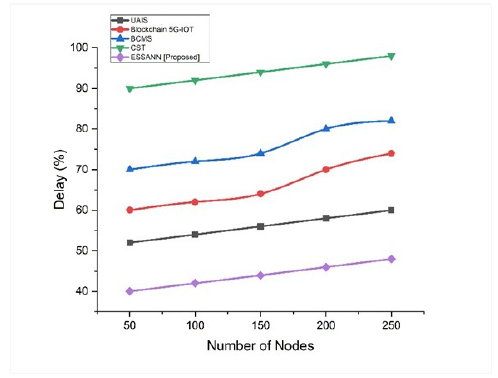
Figure 3. Comparison of delay [23–26].